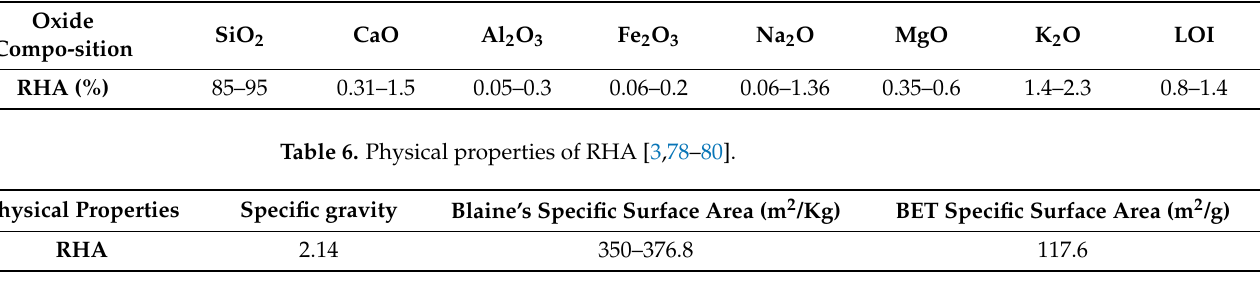
Table 7. Natural fiber chemical and morphological characteristics of RHA [41,81–85].